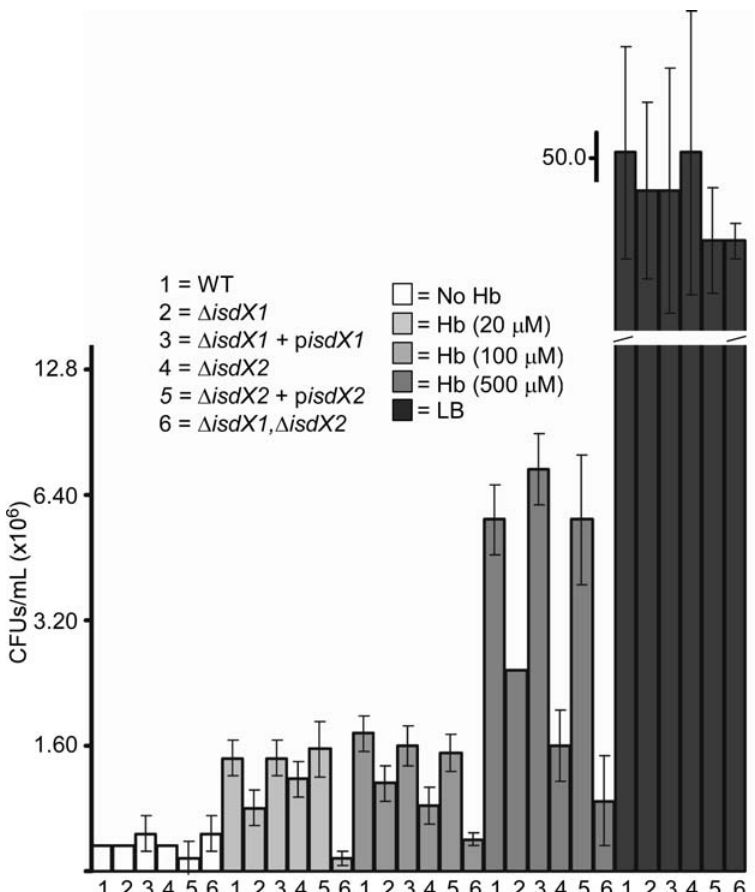
Figure 9. B.anthracis requires isdX1 and isdX2 for scavenging of heme from hemoglobin. B. anthracis strain Sterne (wild-type – WT) and isogenic D isdX1 , D isdX2 , or D isdX1/isdX2 variants were transformed with pLM5 vector, p isdX1 or p isdX2 (encoding IsdX1 or IsdX2 proteins, respectively). Bacteria were grown in iron-replete (LB) or iron-deplete medium (IDM) with the indicated concentrations of hemoglobin at 30 u C for 16 hours. B. anthracis growth was assayed by plating 5 m L of a 1:400 dilution of bacterial culture onto LB/ Km agar plates and colony forming units per mL (CFUs/mL) determined. Mean and standard deviation of three independent experiments are recorded.